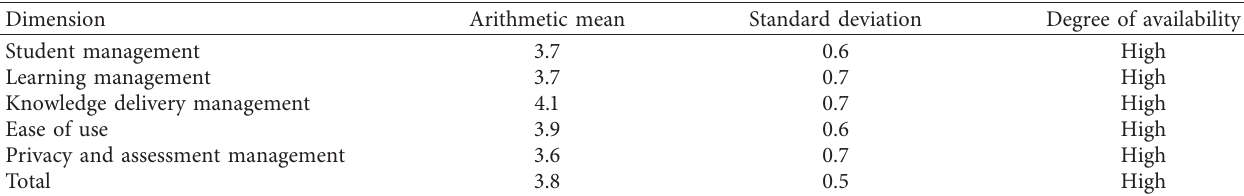
Table 7: Results of the quality scale of programs used in e-learning from the faculty members’ perspective.